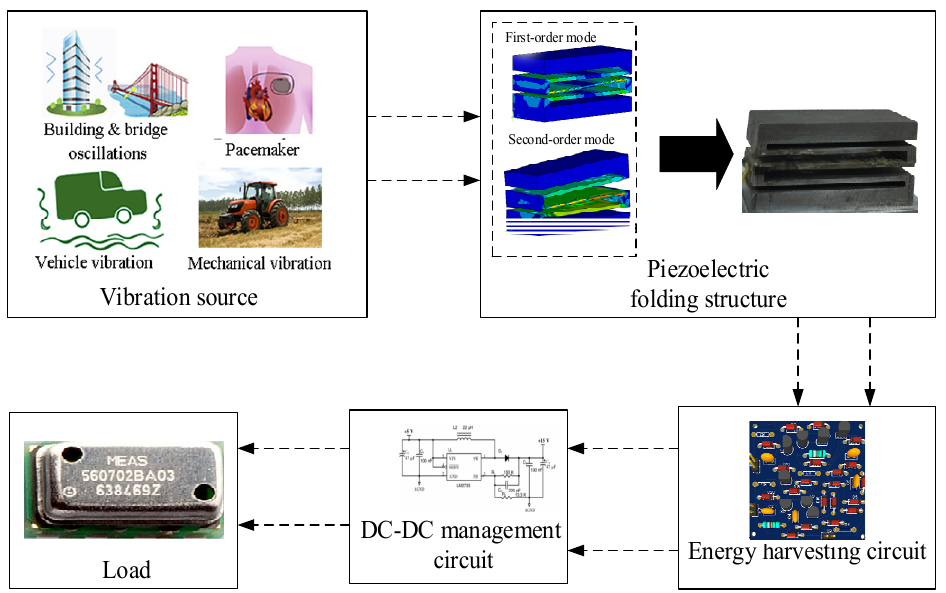
Figure 1. Piezoelectric energy harvesting system.